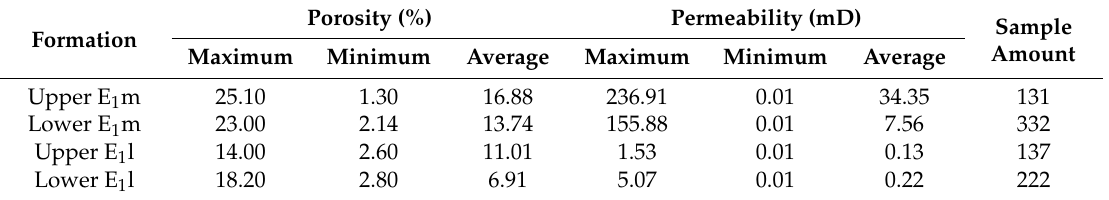
Table 2. The reservoir physical property of the sandstone core samples from the study area. Sample Formation Porosity (%) Permeability (mD) AmountMaximum Minimum Average Lower E 1 m